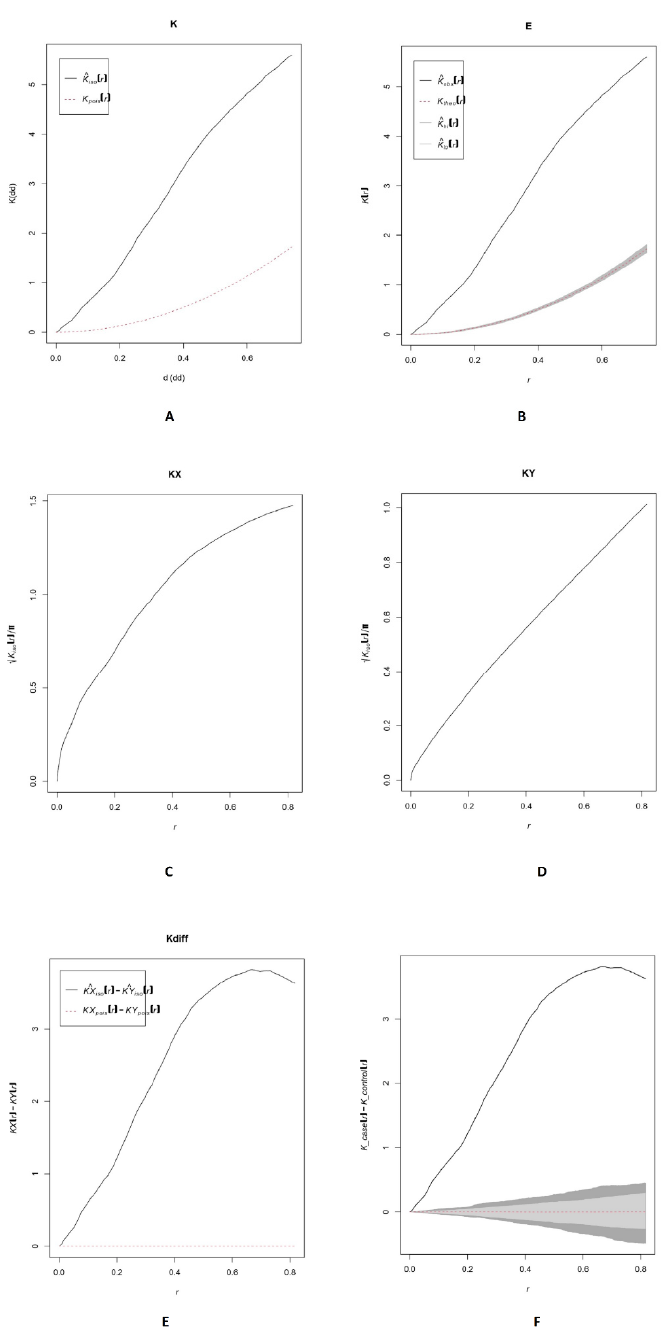
Figure 4. Ripley’s K function for point process pattern and deviation from complete spatial random- ness. Panel ( A ) shows that the actual measured value of K is higher than the theoretically determined anticipated value at all ranges tested, demonstrating significant clustering. Panel ( B ) shows the grey zone as a randomization envelope. Across all distances, actual observed values (K) are much higher than the envelope of predicted K values, indicating significant clustering and divergence from complete spatial randomness. Panel ( C ) shows the actual observed values for cases. Panel ( D ) shows the actual observed values for controls. Panel ( E ) shows differences in actual observed values for cases and actual observed values for controls. Panel ( F ) shows “difference in K function”, denoting that actual observed value of K function is, again, above the grey zone of randomization. Dark grey is minimum/maximum while light grey is the confidence envelope indicating deviation from complete spatial